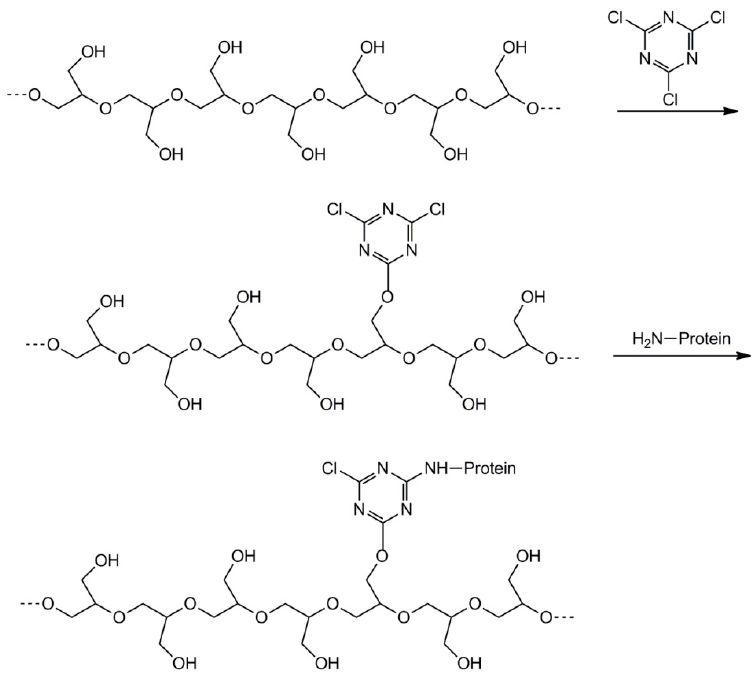
Scheme 26. Attachment of protein to polyglycidol.